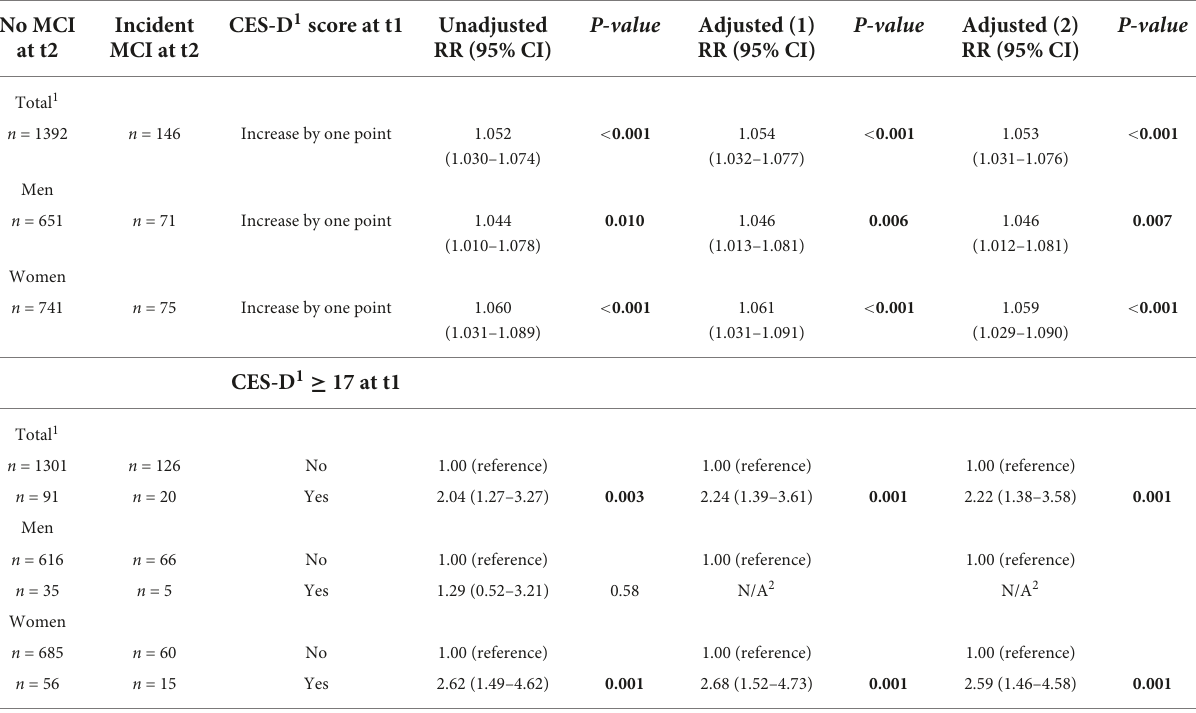
TABLE 2 Association between Center for Epidemiologic Studies Depression Scale (CES-D) score at t1 and CES-D ≥ 17 at t1 and incident mild cognitive impairment (MCI) at t2 for the total sample and stratified by sex. Relative risk for incident MCI at t2 No MCI at